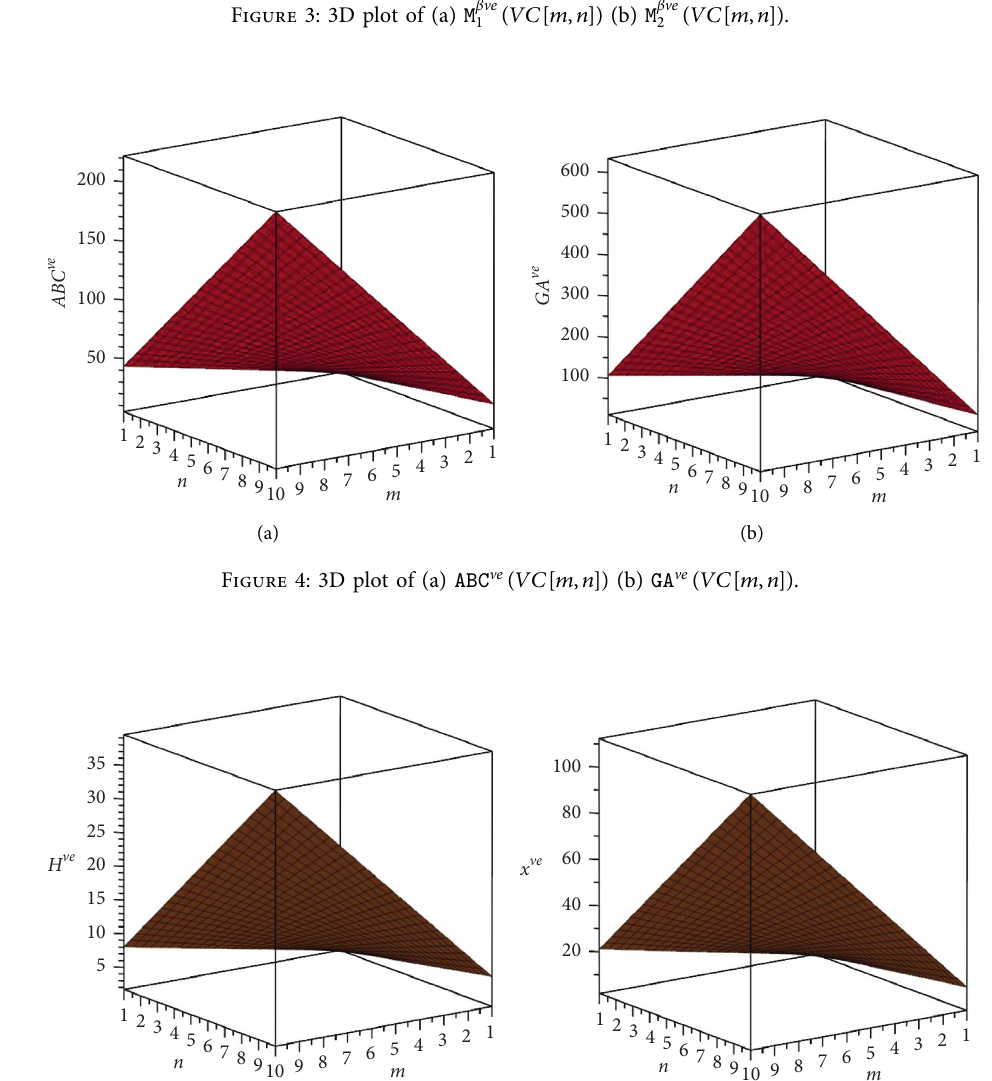
Figure 3: 3D plot of (a) M β ve